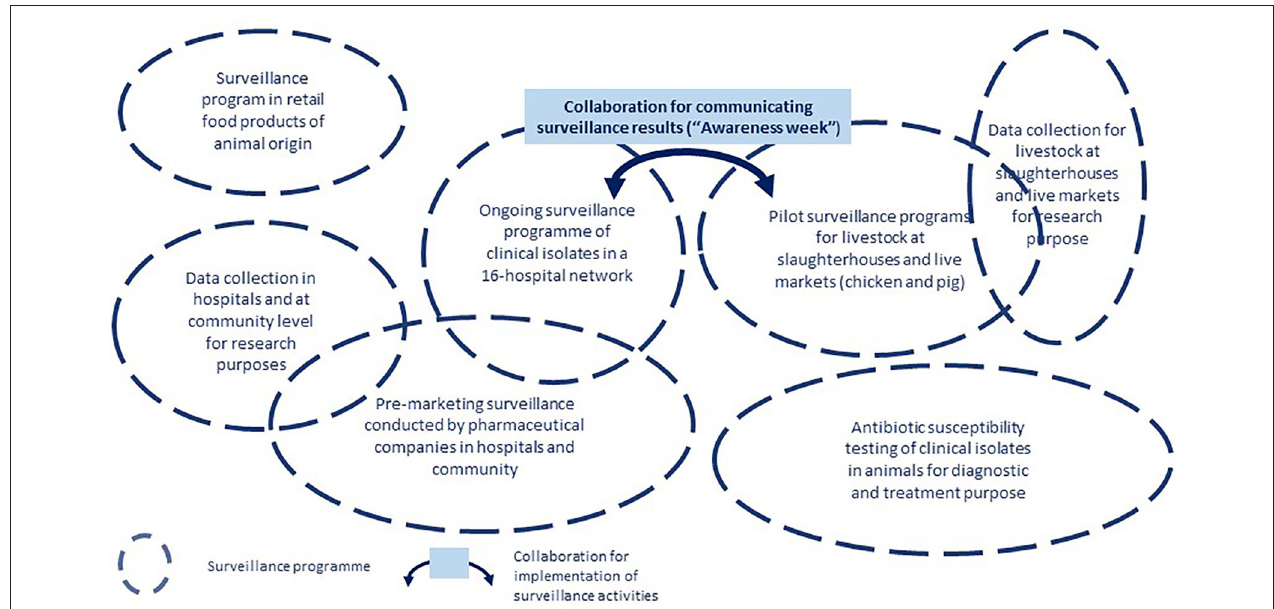
FIGURE 6 | System map of the surveillance of antimicrobial resistance in